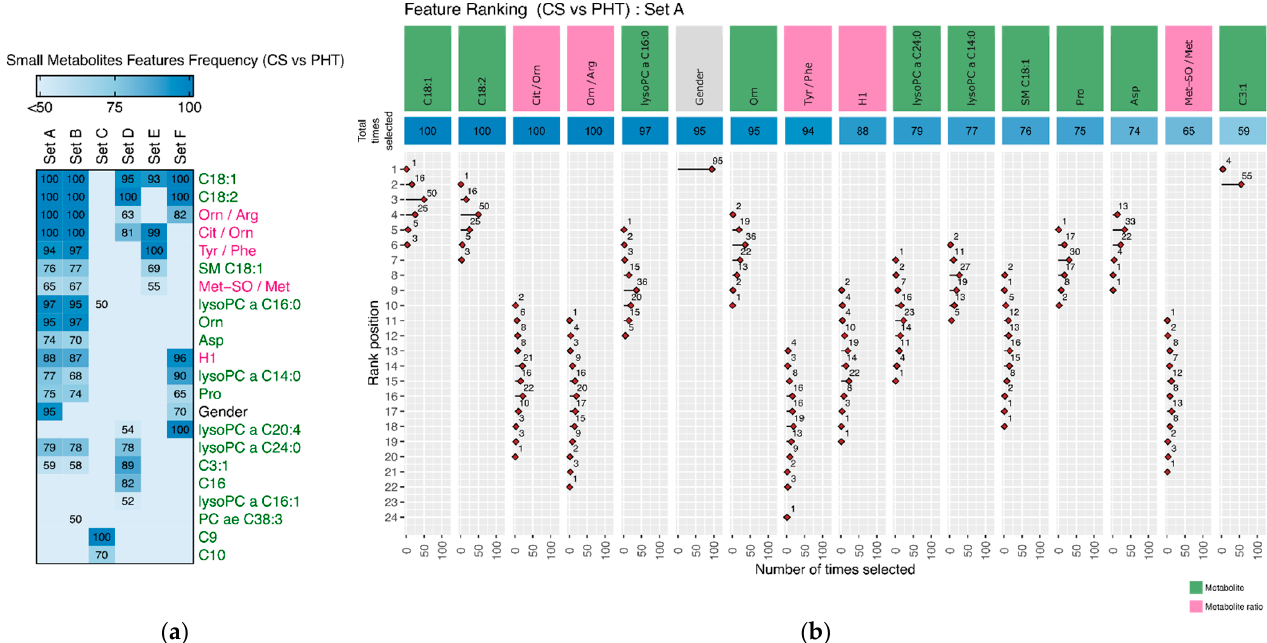
Figure A3. ( a ) Heatmap showing the number of times a feature (metabolites or its ratios) was selected for CS vs. PHT disease comparison in different sets (A–F); ( b ) Feature ranking for Set A in CS vs. PHT disease comparison.